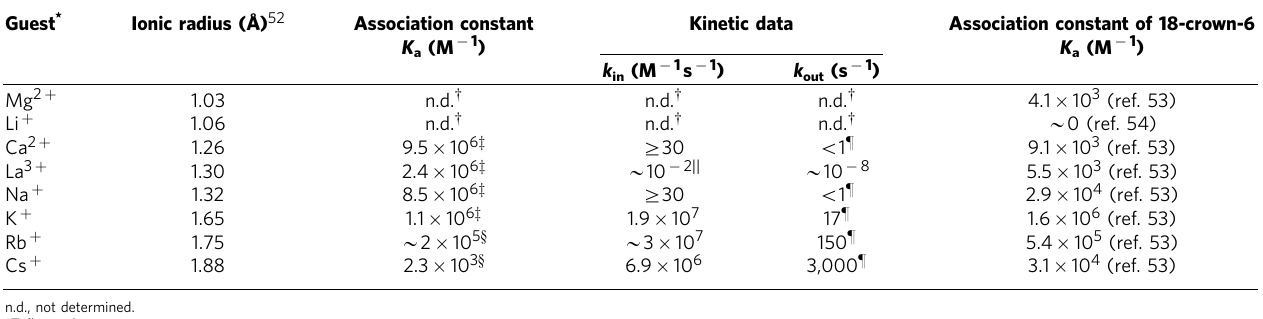
Figure 2 | Na þ encapsulation by anion-capped metallohost. ( a ) 1 H NMR spectral changes of 1 (OTf) 2 upon the addition of NaOTf in CD 3 OD (400MHz, [ 1 (OTf) 2 ] ¼ 1.0mM). ( b ) X-ray crystal structure of [ 1 (cid:2) Na(OTf) 2 ](OTf). Hydrogen atoms are omitted for clarity except for those of the NH 2 groups. The solvent molecules and one triflate anion are also omitted.